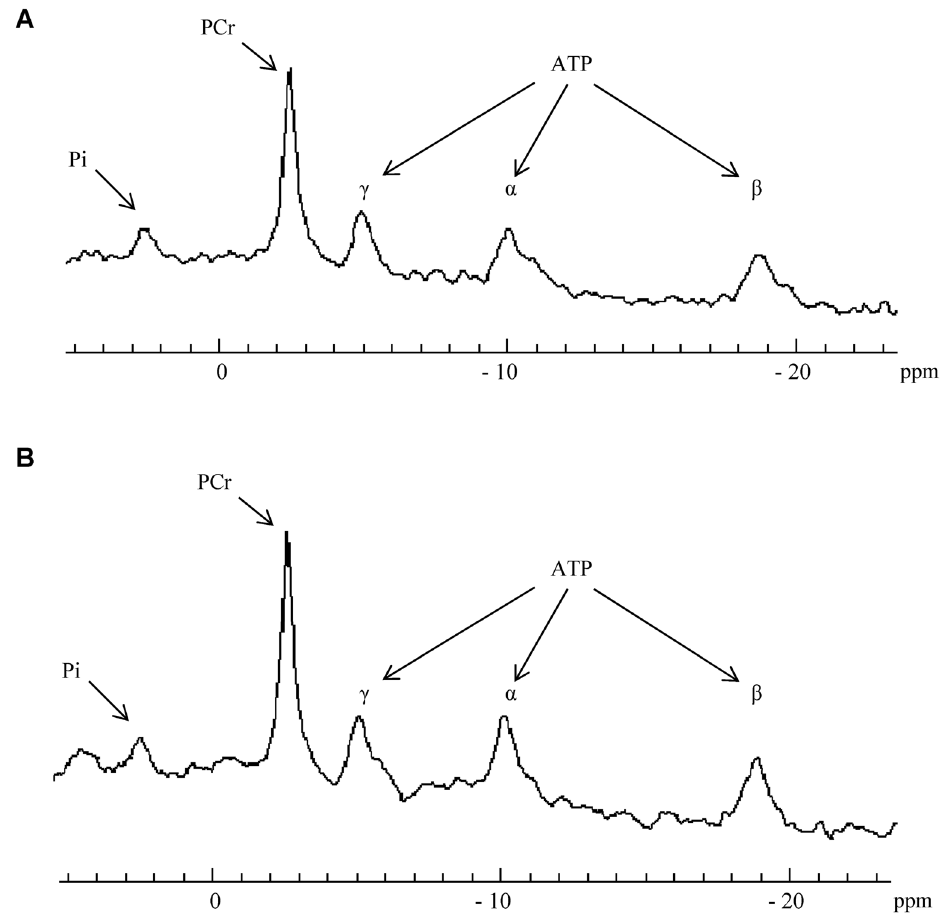
Figure 4. Example of resting 31 P-MR spectra in H40Y group (A) and WT group (B). PCr to ATP ratios were calculated from the peak area of the PCr and b -ATP.